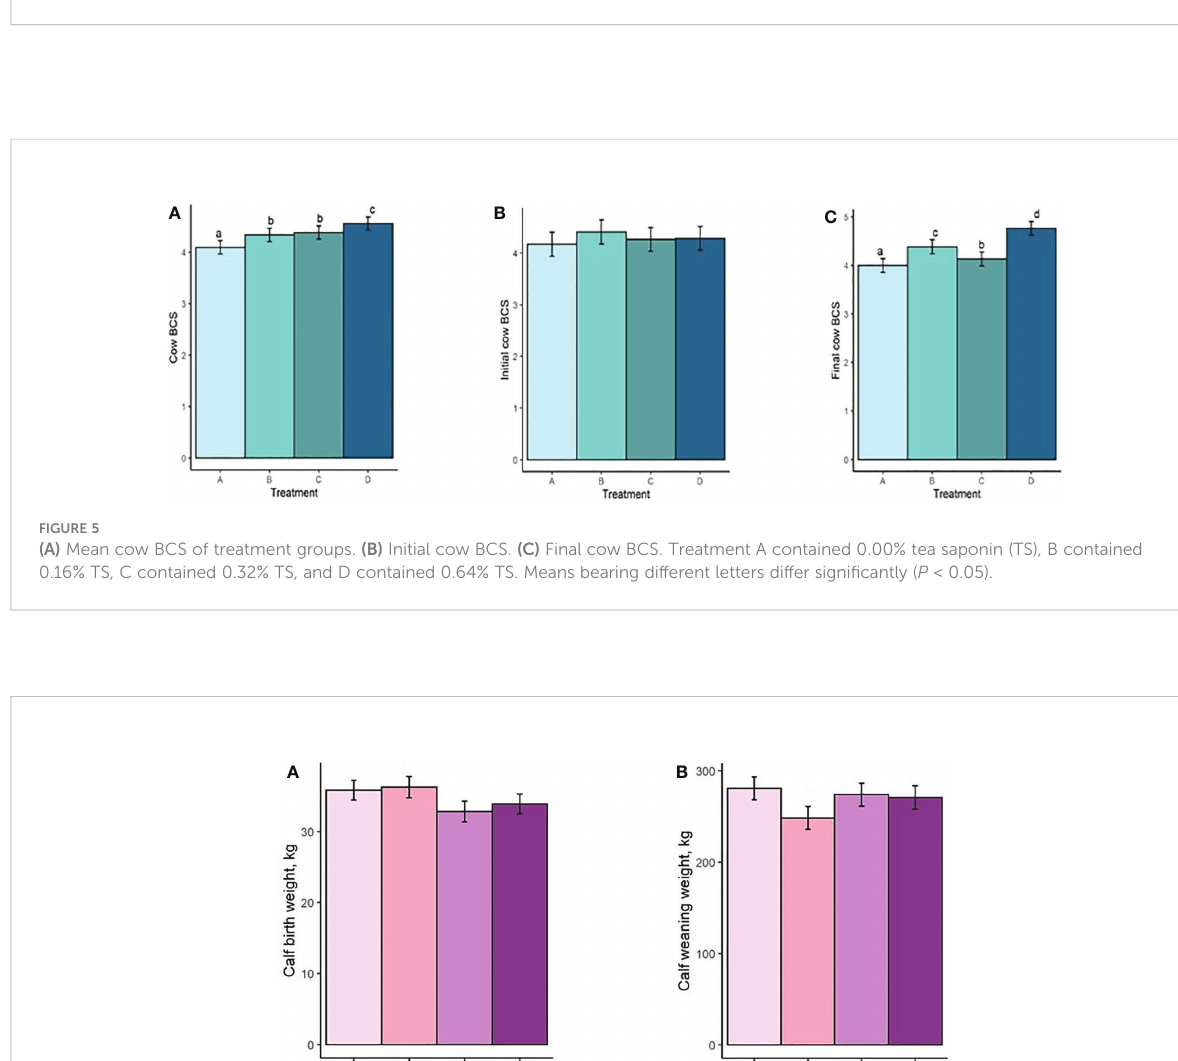
FIGURE 4 (A) Mean cow body weight of treatment groups. (B) Initial cow body weight. (C) Final cow body weight. Treatment A contained 0.00% tea saponin (TS), B contained 0.16% TS, C contained 0.32% TS, and D contained 0.64% TS. Means bearing different letters differ signi fi cantly ( P < 0.05).